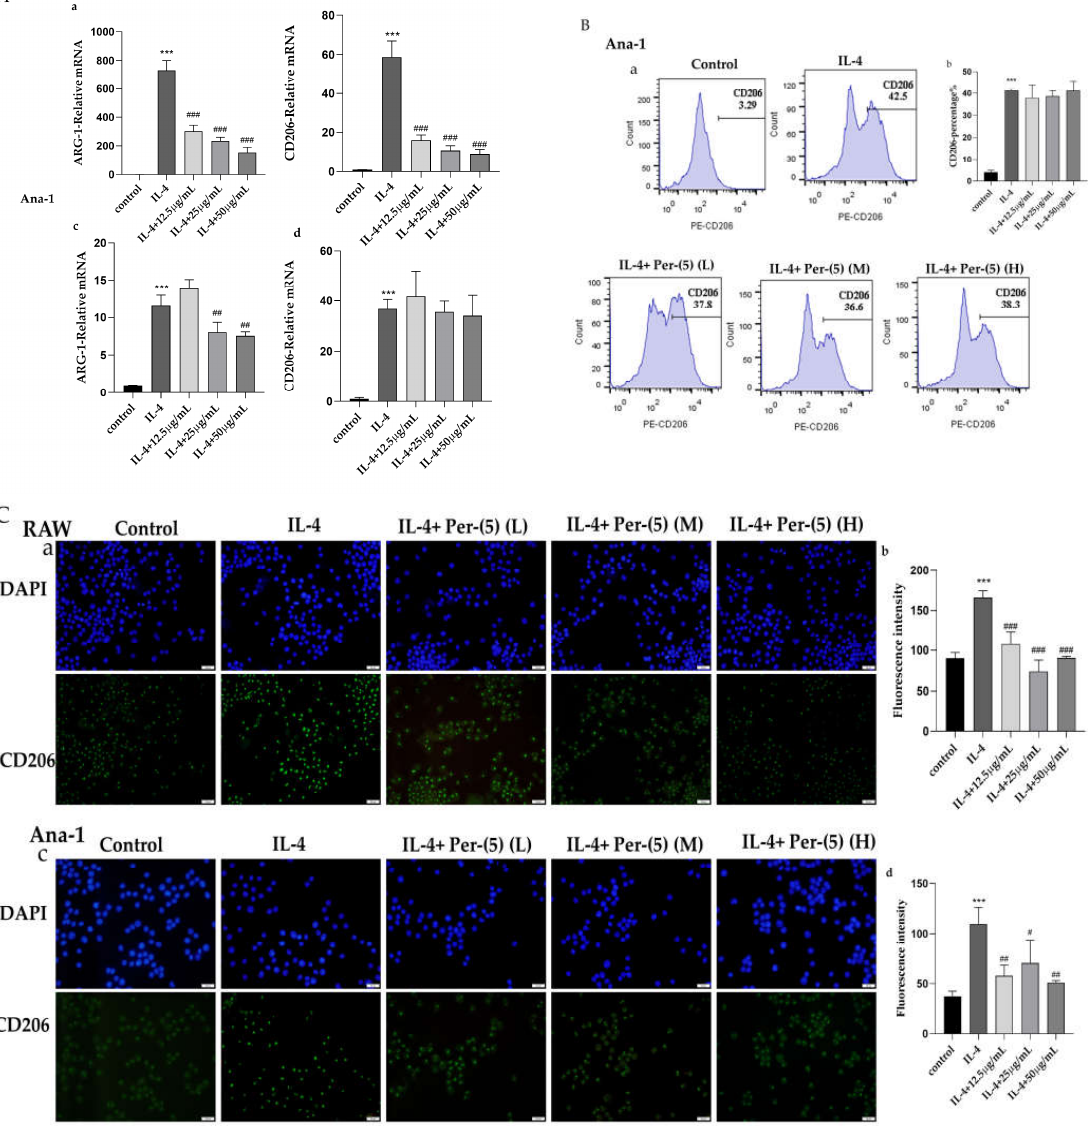
Figure 5. Impact of pericanaside ( 5 ) on the expression of ARG-1 and CD206 in IL-4-induced RAW 264.7 and Ana-1 cells. ( A ): RT-PCR result of ARG-1 ( a , c ) and CD206 ( b,d ) in RAW 264.7 and Ana-1 cells; ( B ): Flow cytometry result of CD206 expression in Ana-1 cells ( a , b ), ( C ): Immunofluorescence result of CD206 expression in RAW 264.7 ( a , b ) and Ana-1 ( c , d ) (scale bar = 20 µ m). *** p < 0.001 vs. the control group; # p < 0.05, ## p < 0.01, and ### p < 0.001 vs. the IL-4 group.